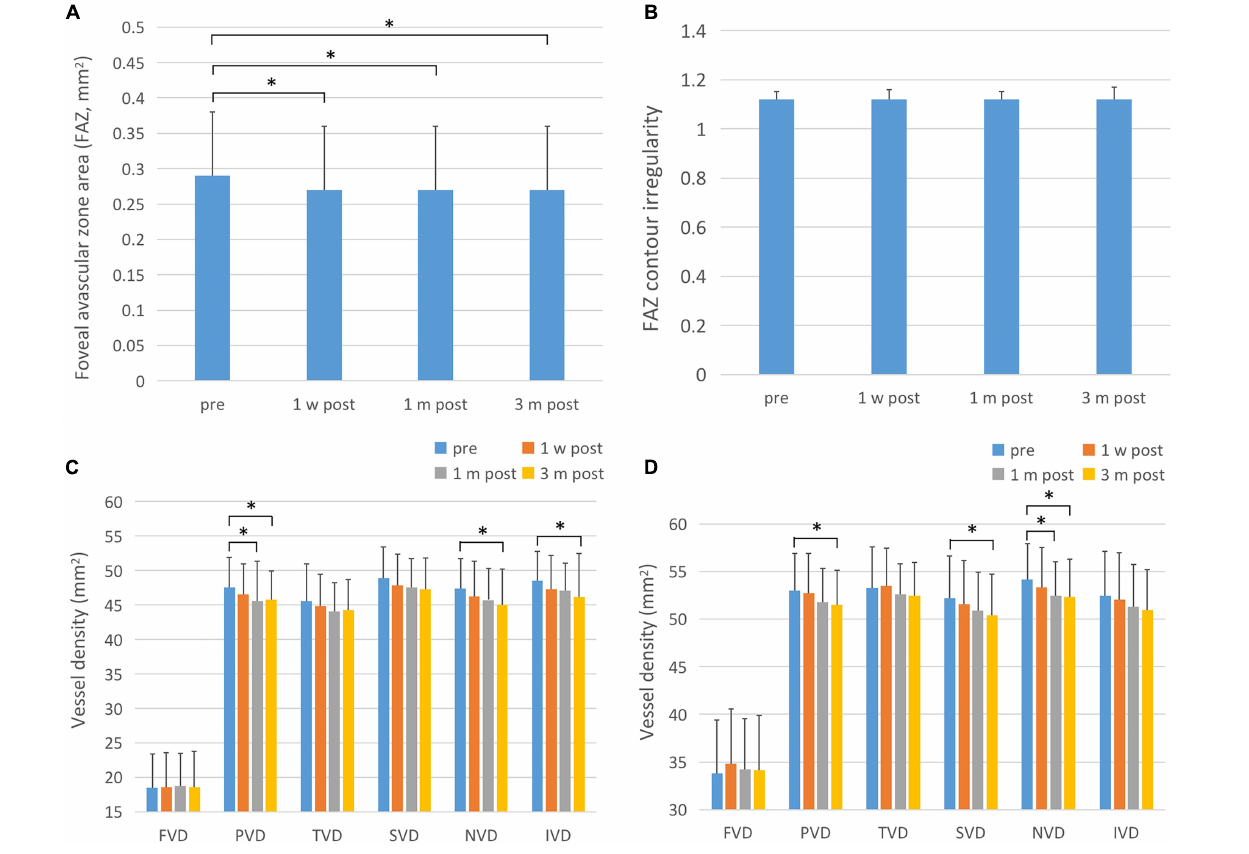
FIGURE 3 | FAZ-A, FAZ-CI, and blood flow changes in the fovea and parafoveal area after ICL implantation. (A) The changes in FAZ-A after operation. The FAZ-A values at various time points after surgery were significantly lower than those before surgery. (B) Post-operative FAZ-CI changes, showing that there is no statistical difference between post-operative and pre-operative values. (C) Changes in superficial retinal blood flow after surgery. The PVD, NVD, and IVD were significantly reduced 3 months after surgery. One month after surgery, PVD was also significantly reduced compared to pre-operative values. (D) Postoperative changes of deep retinal blood flow. The PVD, SVD, and NVD were significantly reduced at 3 months after surgery, and NVD was significantly decreased 1 month after surgery. The short black line shows that the data at the corresponding two time points were statistically different. * P <